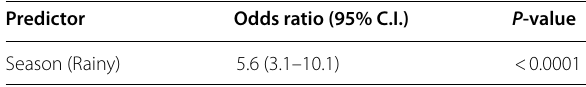
Table 3 Factors significantly associated with coronavirus RNA positive results in E. gambianus bats sampled from February 2017 – December 2018 in the Boabeng‑Fiema area in Ghana as identified by logistic regression analyses